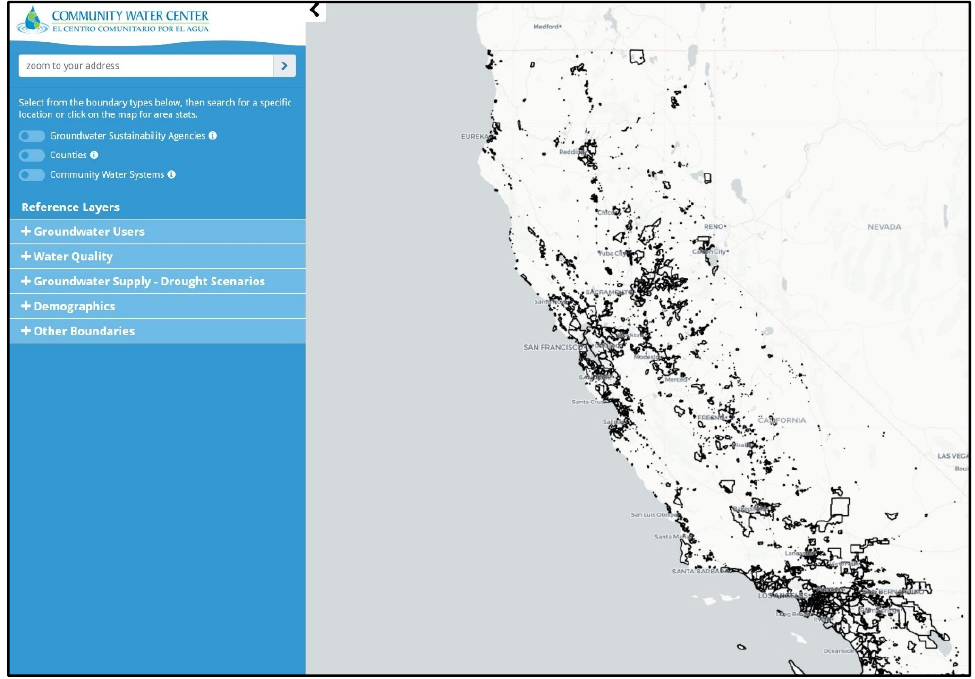
Figure 1. Screenshot of the Drinking Water Tool displaying community water system boundaries for the entire state of California (https://drinkingwatertool.communitywatercenter.org/ca-water/, accessed on 30 November